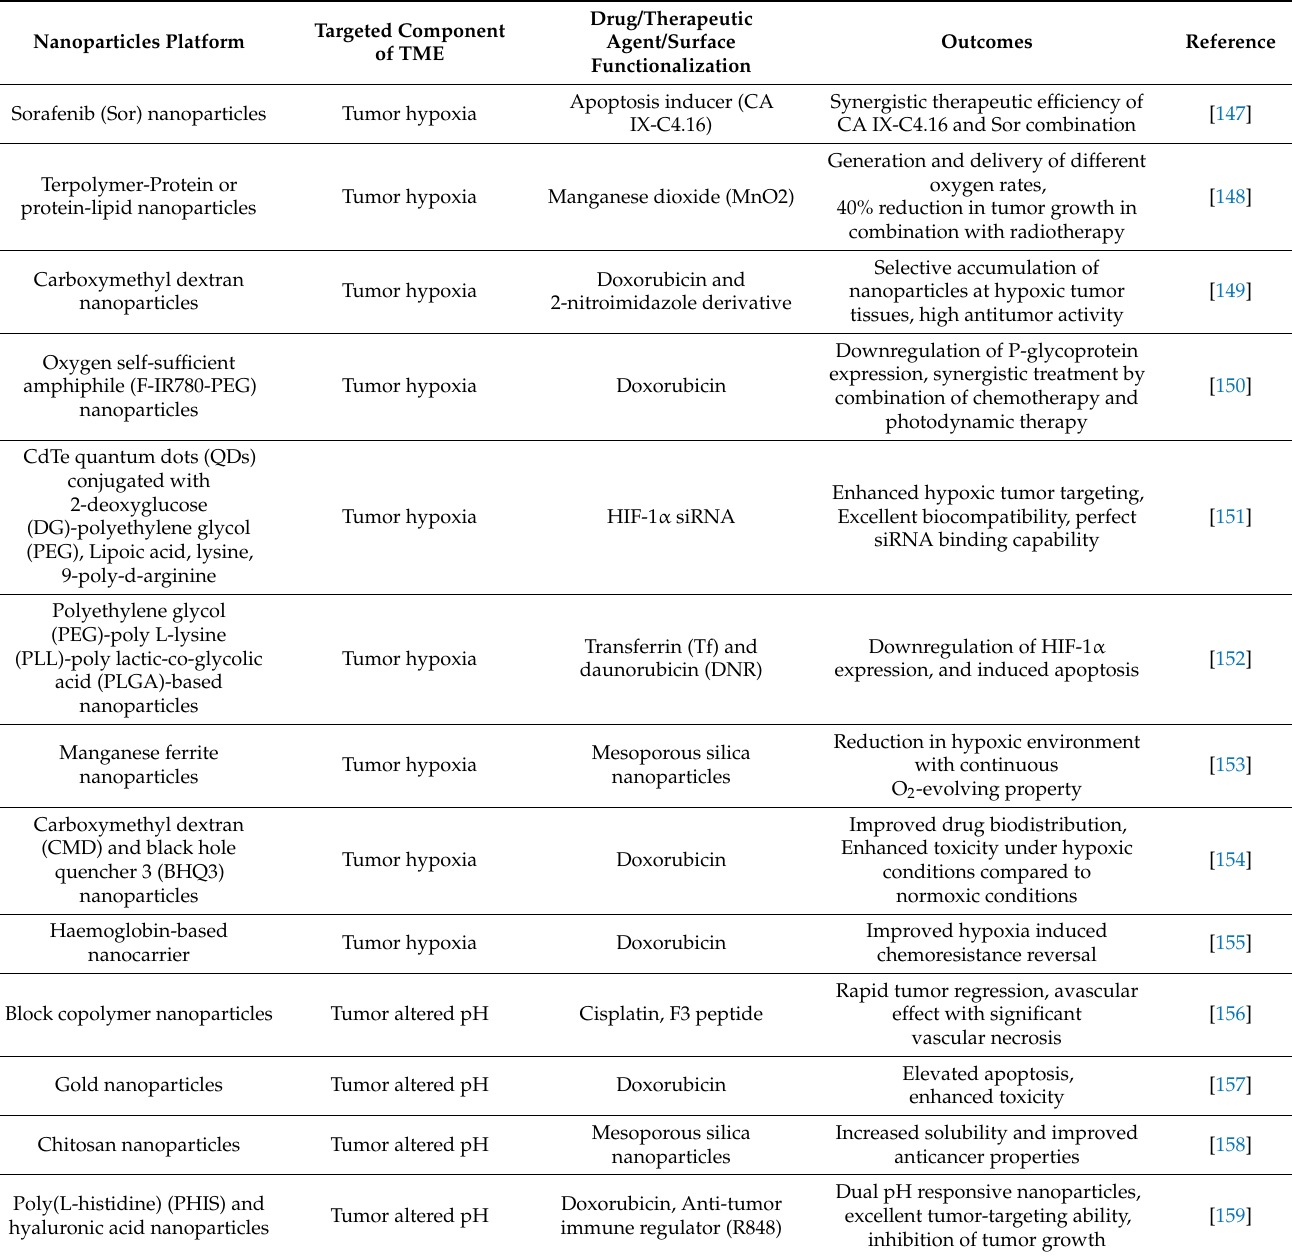
Table 3. Nanotherapeutic approaches to target non-cellular components of tumor microenvironment for overcoming cancer drug